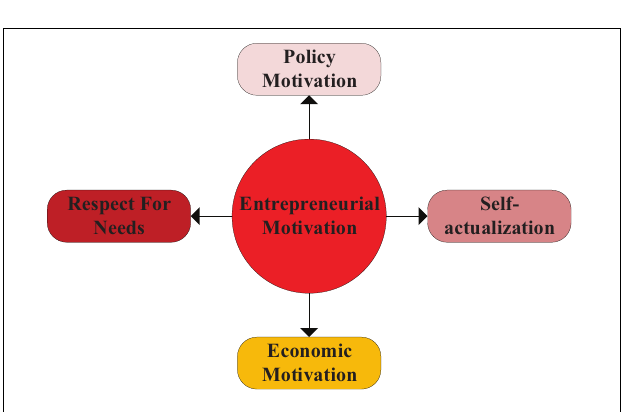
FIGURE 4 | Variable indicators of entrepreneurial motivation.